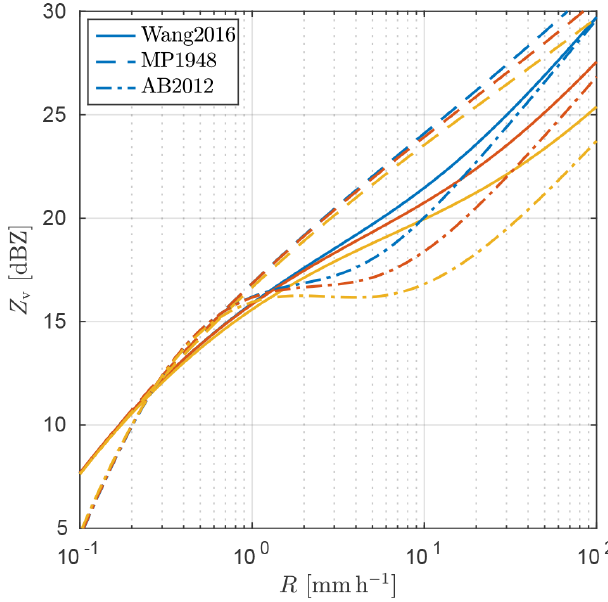
Figure 3. Vertically polarized radar reflectivity Z v , shown in units of dBZ, as a function of rainfall rate R at 94.1GHz, for different PSDs. Zenith-looking geometry is assumed. The line colours are the same as for Fig. 2.